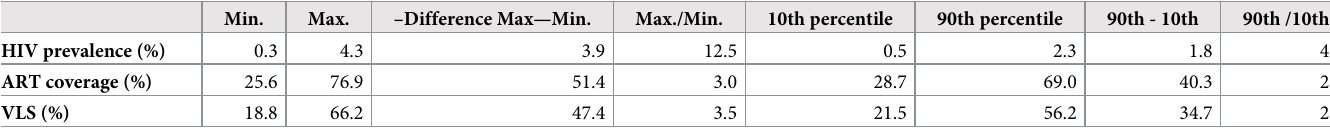
Table 1. Differences in estimated HIV indicators between states � (n = 37) in Nigeria (2018).